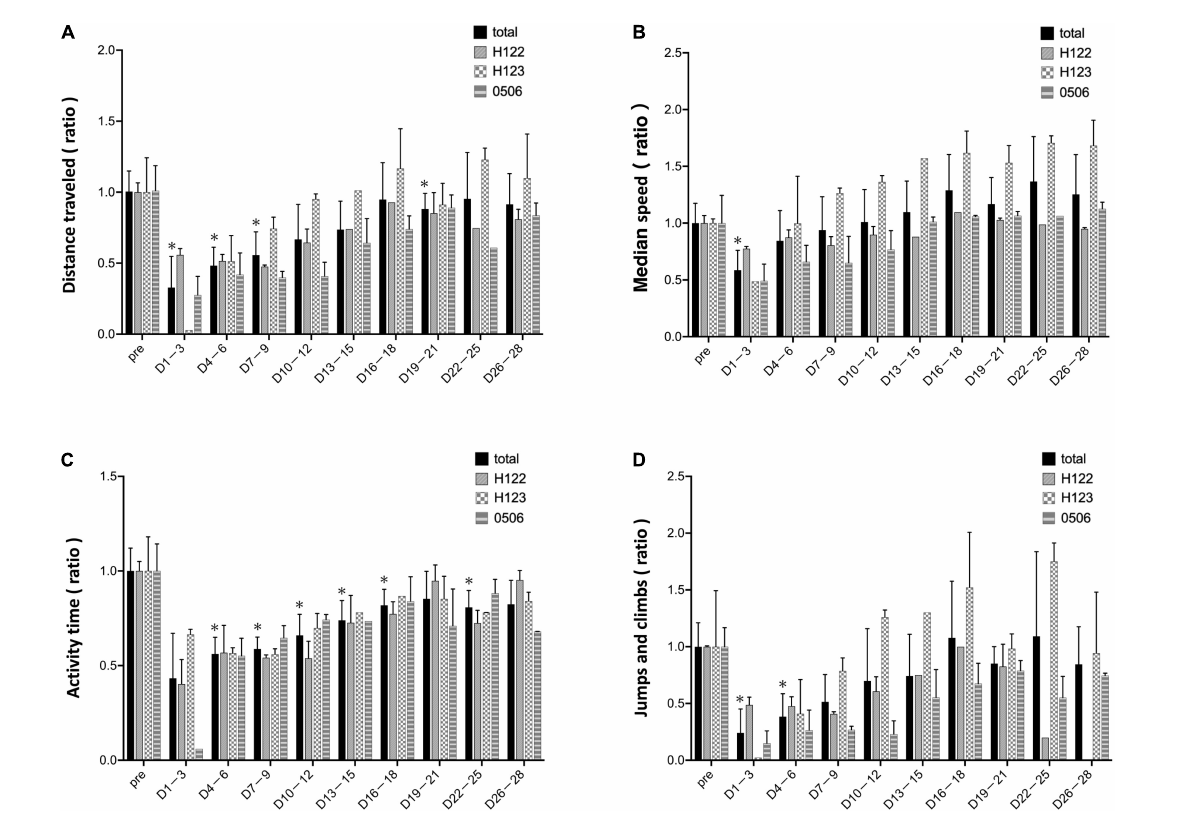
FIGURE4 Evaluation based on MarmoDetector The bar shows data from each animal in individual lines besides total. (A) Y -axis indicates the ratio of preoperative/postoperative distance traveled. The distance traveled dropped immediately after the stroke, and gradually improved, recovering to the same level as that before the stroke at 16–18 days after stroke. (B) Y -axis: the ratio of preoperative/postoperative median movement speed. The travel speed dropped immediately after the stroke, and then significantly improved on days 4–6, recovering to the same level as that before the stroke on days 10–12. (C) Y -axis: the ratio of preoperative/postoperative activity time. Activity time had improved slightly after stroke. (D) Y -axis: the ratio of preoperative/postoperative jumps/climbs. Jumps/climbs is the number of frames that moved vertically above 120 cm/s. Jumps/climbs tend to decrease during the first postoperative week, but the recovery process appears to vary from individual to individual. Postoperative values are shown as means and standard errors for every 3 days. ∗ P < 0.05 in comparison with preoperative values indicating the presence of deficits (paired t